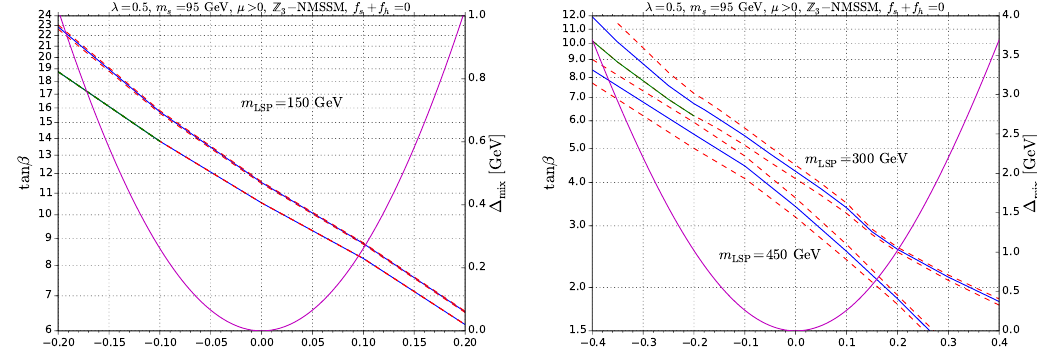
Figure 8 . Contour lines of (cid:10) h 2 = 0 : 10 ; 0 : 12 ; 0 : 14 as functions of tan (cid:12) and (cid:13) in the Z 3 -invariant NMSSM. Left panel: resonant annihilation via a exchange for m LSP = 150 GeV. Right panel: non- resonant annihilation for m LSP = 300 and 450 GeV. The green parts of the contours are excluded by LUX. The parabola-like curves show dependence of (cid:1) mix (on the right horizontal axes) on (cid:13)